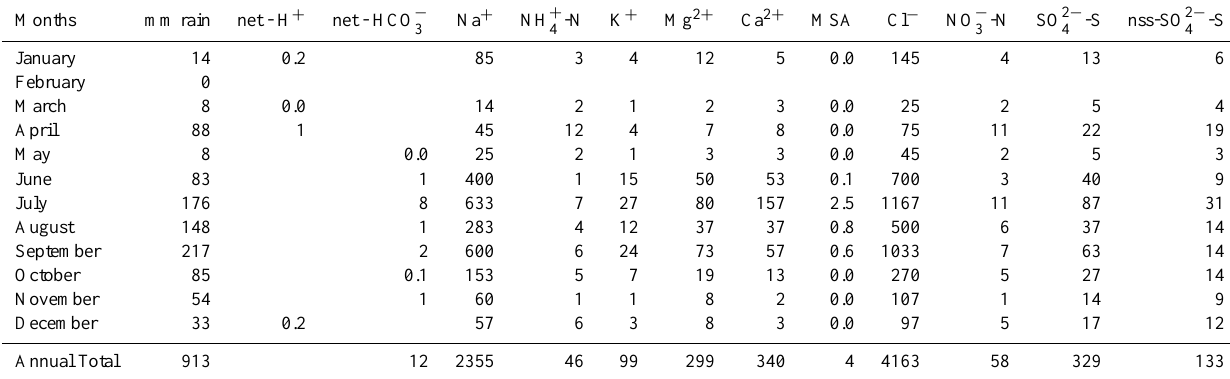
Table 8. Wet deposition of net acidity and net alkalinity (in mmolm − 2 ) and other rainwater components (in mgm − 2 ) by month and as annual total. ∗ Net acidity and net alkalinity deposition is obtained by summation over daily values with either H + deposition (as positive) or HCO − deposition (as negative). Monthly total is net-H + if positive otherwise net-HCO − 3